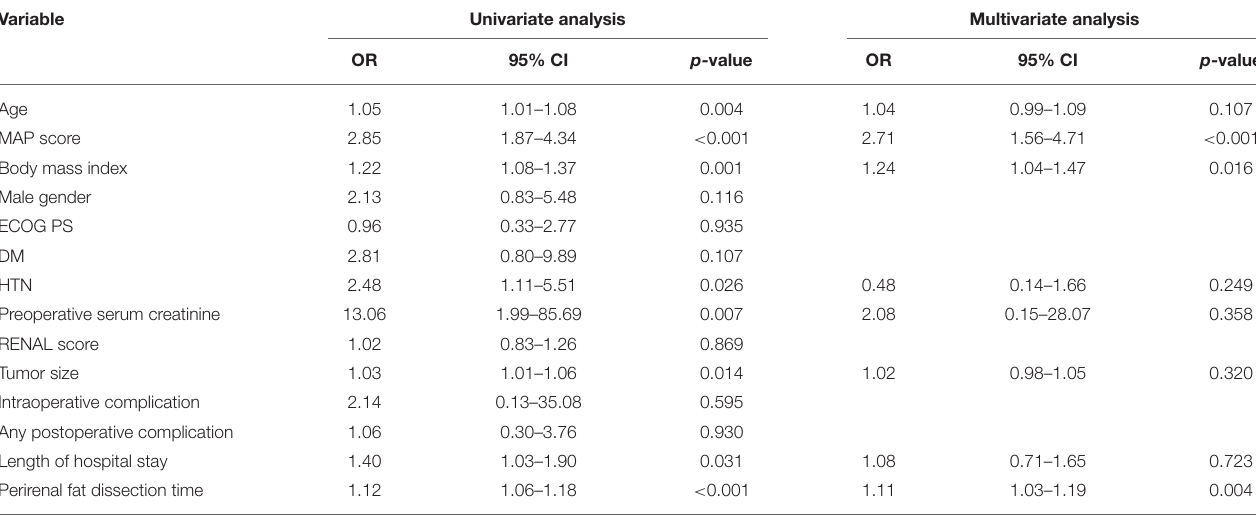
TABLE 2 | Associations of APF presence during robot-assisted partial nephrectomy (RAPN) with perioperative factors.